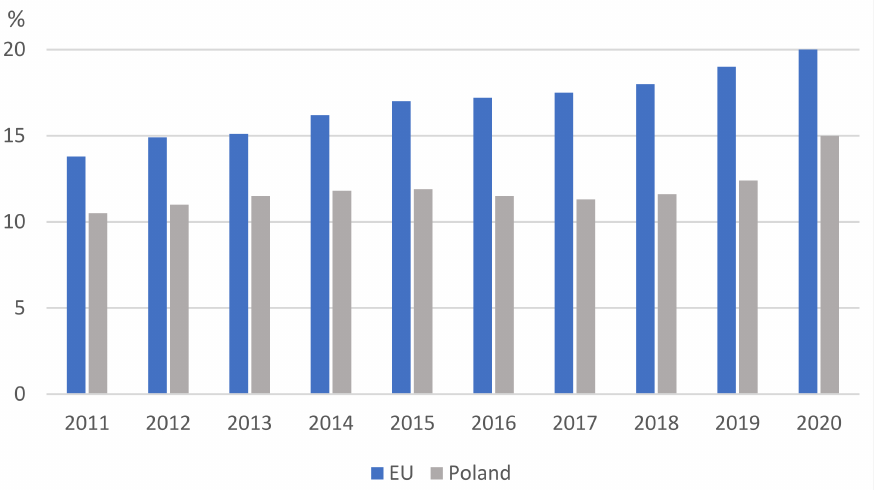
Figure 1. Share of renewable energy sources in gross final energy consumption. Source: Own study based on [15].